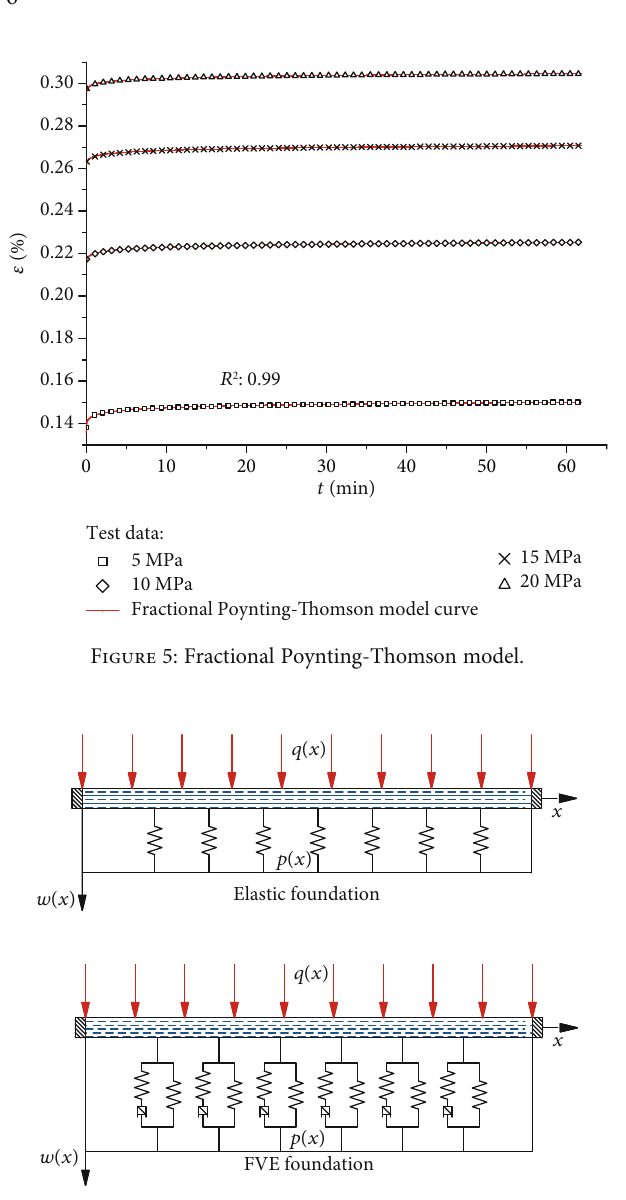
Figure 6: Fractional viscoelastic and elastic foundation